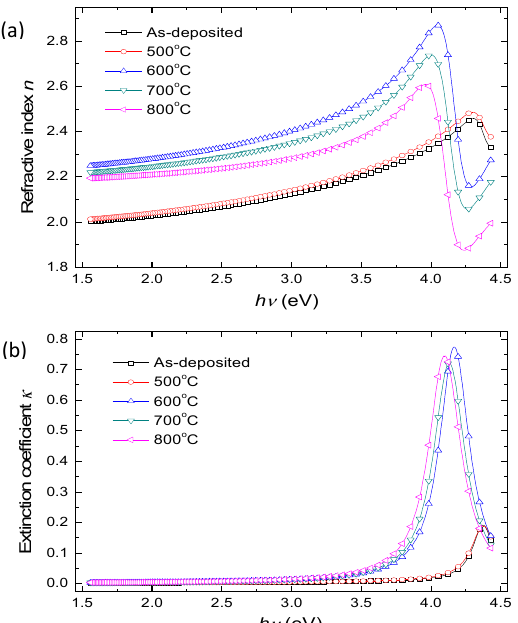
Figure 6. The calculated ( a ) refractive indices and ( b ) extinction coefficients of SrTiO 3 thin films prepared at different temperatures.